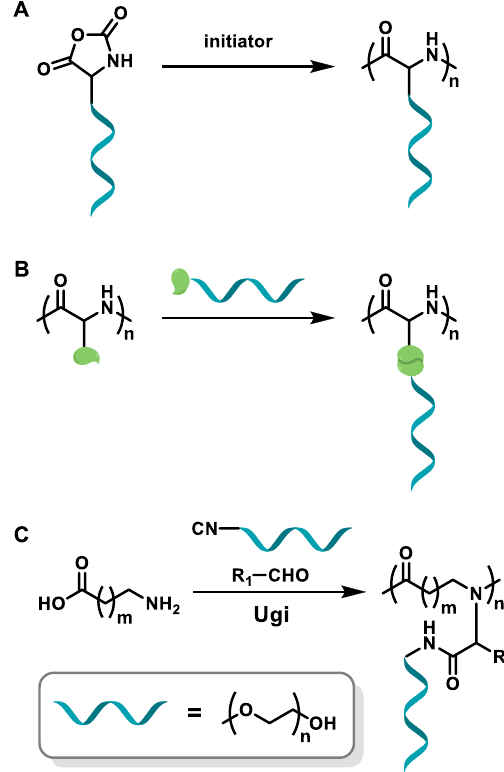
Figure 1. Synthesis strategies of OEGylated poly(amino acid)s. ( A ) ROP of OEGylated NCAs, ( B ) post-polymerization modification of poly(amino acid) precursors, and ( C ) Ugi multicomponent polymerization.